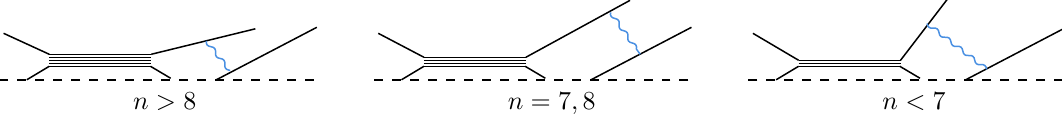
Figure 3 . D1’-branes (blue) create hypermultiplet particles in the spinor representation. gauge theory with n ≤ 6 , the “leg” fivebranes do not intersect. For n = 7 , 8 , the two “leg” fivebranes are parallel to each other. In fact, from this viewpoint of quantum mechanics on D1-D1’-branes, the SO( n ) instanton moduli spaces with spinor matter are described using the ADHM approach in [20]. The results are reviewed in appendix